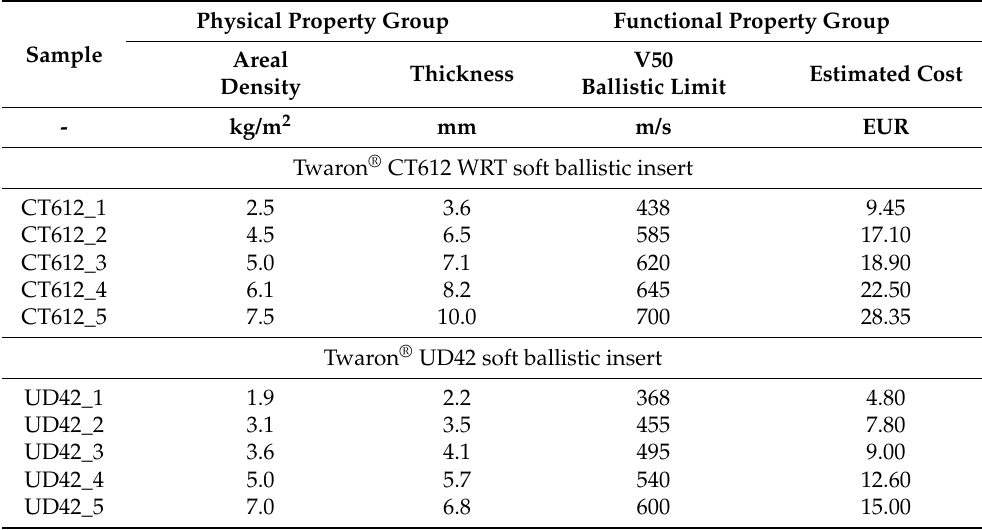
Table 5. Parameters of the designed para-aramid soft ballistic inserts assigned to two groups: physical and functional properties.